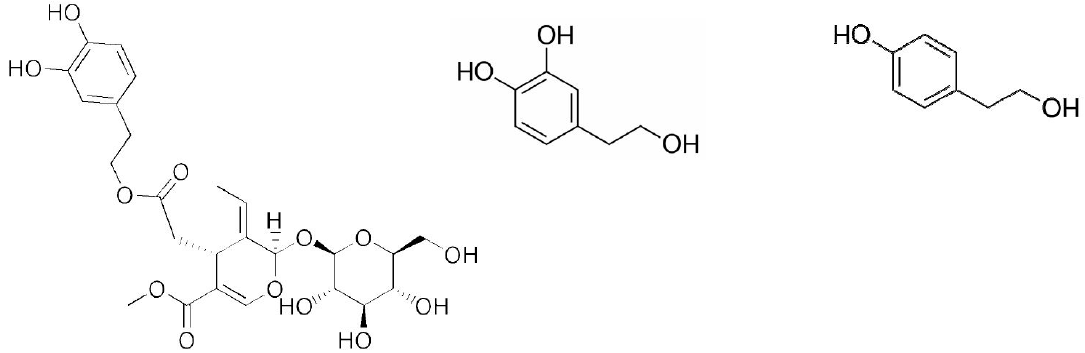
Figure 1. Structures of: oleuropein ( left ); hydroxytyrosol ( middle ); and tyrosol ( right ).